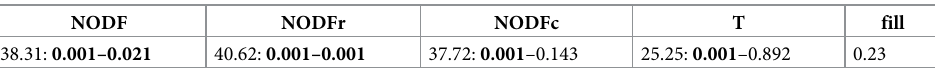
Table 2. Nestedness indices for dry grassland ant assemblages in Guadarrama range. NODF NODFr NODFc T fill 38.31: 0.001–0.021 37.72: 0.001 –0.143 25.25: 0.001 –0.892 0.23 Nestedness indices derived from the Nestedness metric based on Overlap and Decreasing Fill (NODF), NODFr for rows (i.e. localities) and NODFc for columns (i.e. species) and matrix temperature (T). Numbers under headings for indices provide the index values followed by P -values estimated by equiprobable (‘r00’) and proportional resampling (‘quasiswap’) binary null models. Significant P -values ( P < 0.05) are in bold face. Fill: matrix fill (sum of 1s/sum of cells). Data from 2014 in Guadarrama (18 grasslands, 35